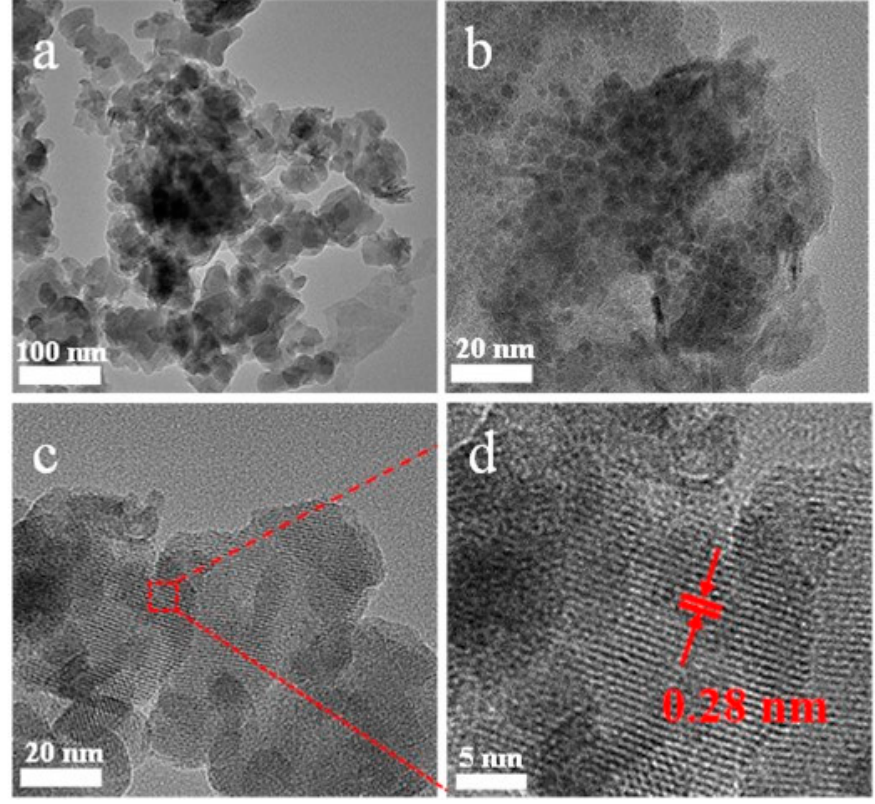
Figure 5. ( a – d ) TEM and HRTEM images of the prepared NiMo-LDH@NiCo-MOF.